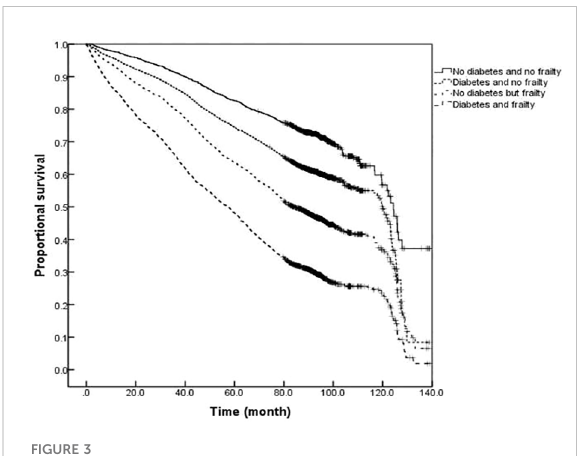
FIGURE 4 Kaplan-Meier curves for the proportional survival of older adults aged 60- years with different diabetes and frailty status.